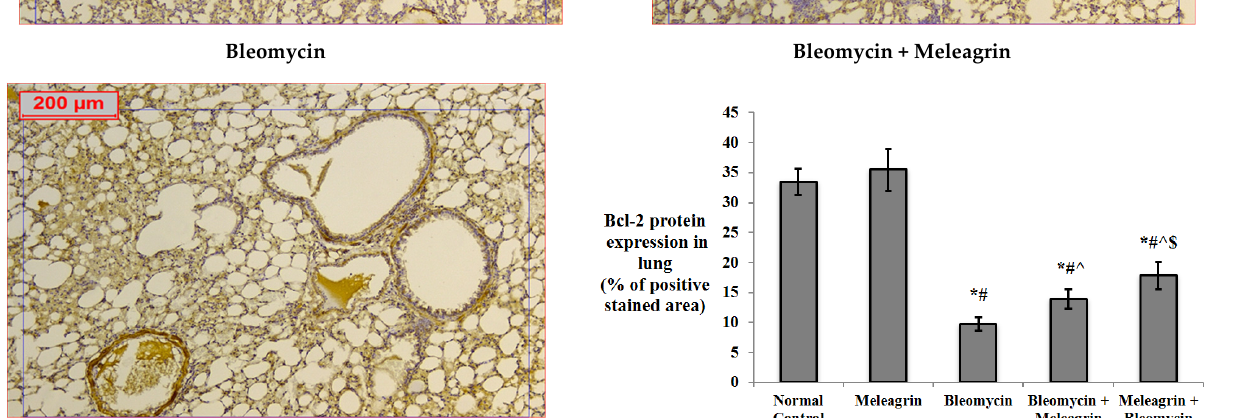
Figure 8. The effect of meleagrin on the protein expression levels of Bcl-2 in the lung tissue of the experimental mice determined by immunohistochemistry. Bcl-2 = B cell lymphoma-2. Data of the percentage of positive stained area are expressed as mean ± SD and analyzed using one-way ANOVA followed by Bonferroni’s post hoc test ( n = 8). * significantly different vs. the normal control group; # significantly different vs. the meleagrin group; ^ significantly different vs. the bleomycin group; $ significantly different vs. the bleomycin + meleagrin group. Differences were considered significant at p < 0.05.